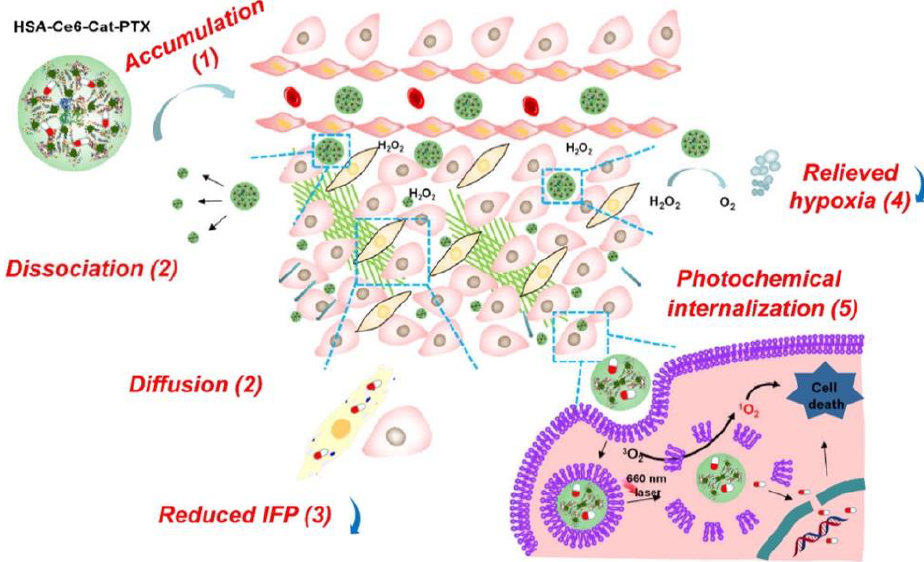
Scheme 3. Schematic representation of the mechanisms of action of HSA-Ce6-Cat–PTX NPs.